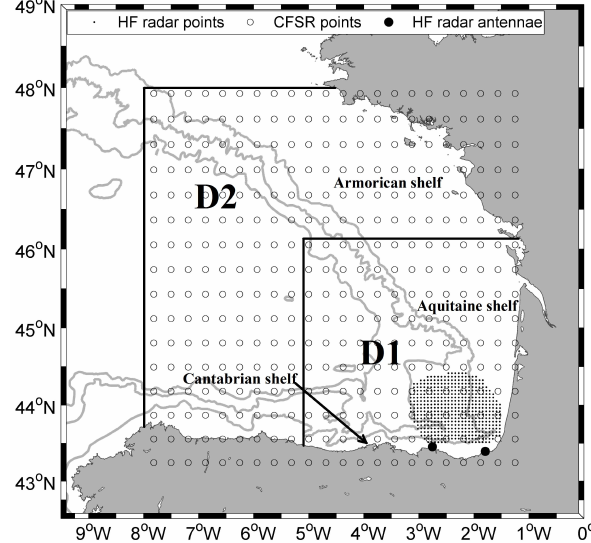
Fig. 1. Location of the study area showing the position of the HF radar points with more than 50% data coverage, CFSR grid points, HF radar antennae and the two spatial domains considered (D1 and D2). Bathymetric contours show the 200-, 2000- and 4000-m iso-